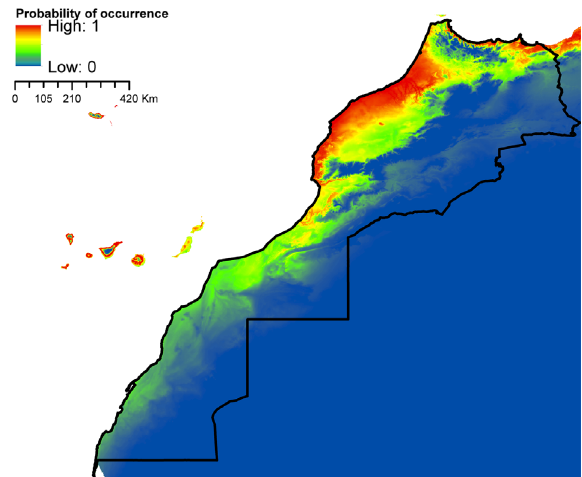
Figure 6. Predicted distribution of Ae. detritus in Morocco.